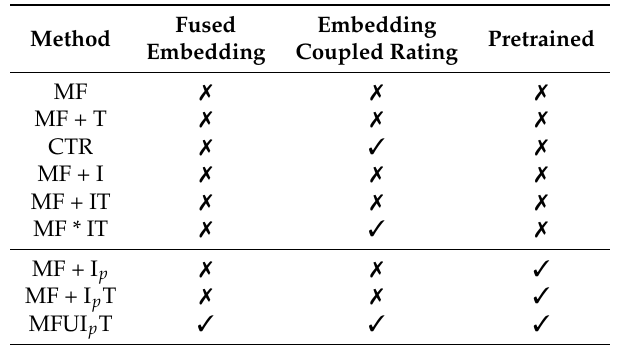
Table 2. Comparison of